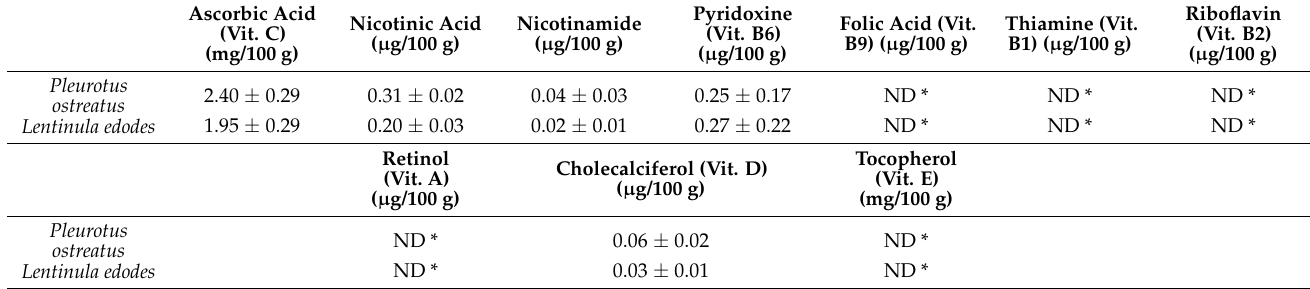
Table 3. Water-and fat-soluble vitamin contents of Pleurotus ostreatus and Lentinula edodes extracts. Ascorbic Acid (Vit.